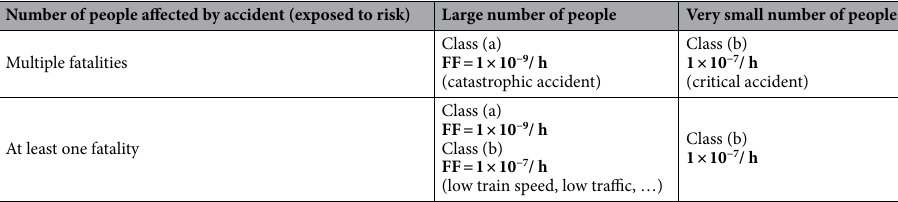
Number of people affected by accident (exposed to